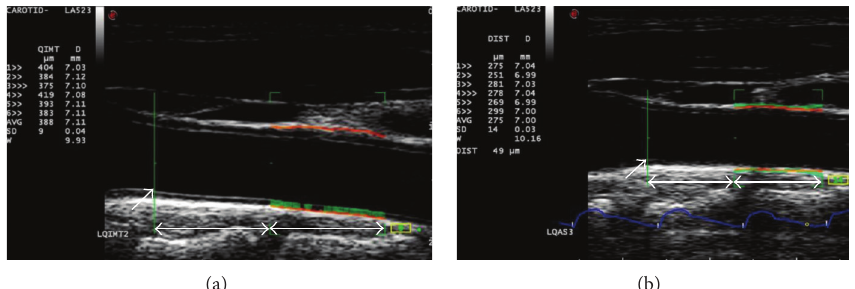
Figure1:Theassessmentofintima-mediathicknessandarterialstiffnessinthecarotidartery.(a)Radiofrequency-basedqualityintima-media thickness. (b) Radiofrequency-based quality arterial stiffness. The arrows indicate the inferior end of the carotid bulb and the double-arrow lines show a distance of